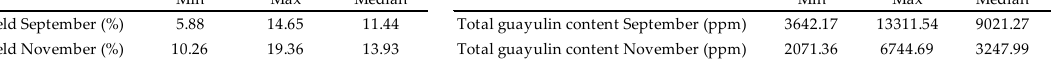
Figure 3. Relation of resin yield and total guayulins content in guayule stems between November and September in different guayule accessions. Bars represent the ratio of resin percentage (blue color) to guayulins content (orange color) in November versus September. The red line represents the same proportion in both harvesting times, whereas the red arrows highlight the guayule accessions without a significant decrease in resin content in the November harvest. Orange arrow represents the guayule accession in which total guayulins content does not decrease in the November harvest.